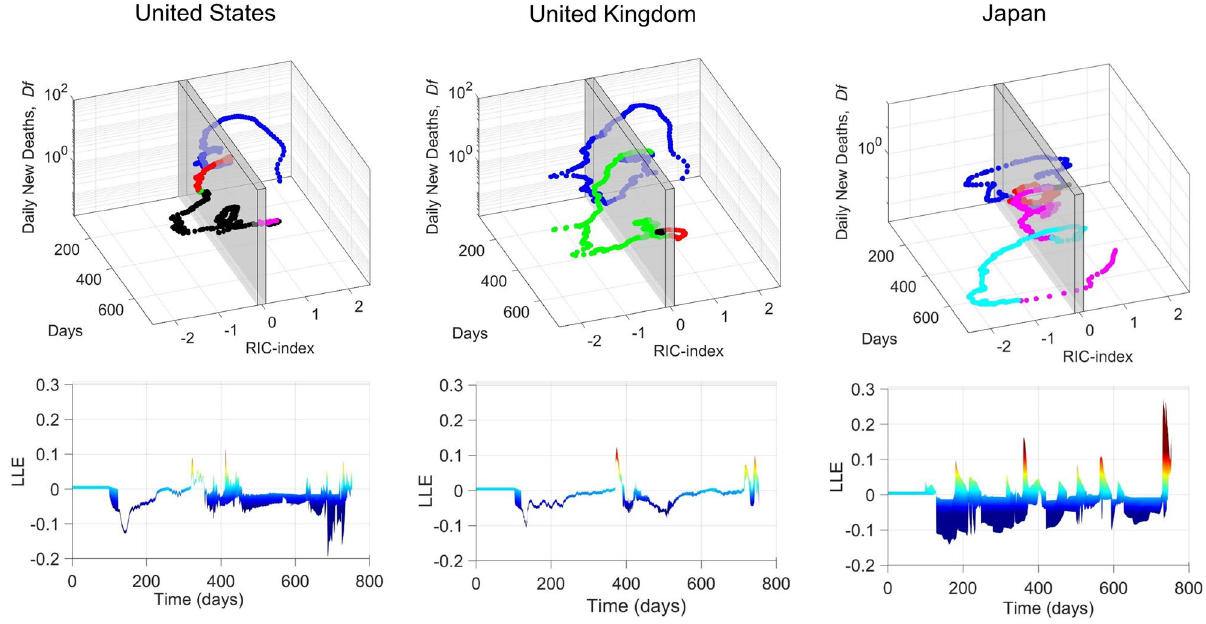
Figure 3. 3D helicoid vortex and Lyapunov Maps of epidemic spreading from 15/03/2020 to 28/01/2022 in United States, United Kingdom and Japan. In the upper panels we show the 3D orbit of the Covid-19 vortex over which separates the supercritical ( RIC index > 0) and the subcritical regime ( RIC index < 0). The lower panels represent the Lyapunov maps. The discontinuity points, where the LLE integrated along the different initial ranges change sign becoming positive, correspond to times in which the helicoid vortex change color. Non- positive LLE values imply convergent trajectories independent by the initial conditions of the